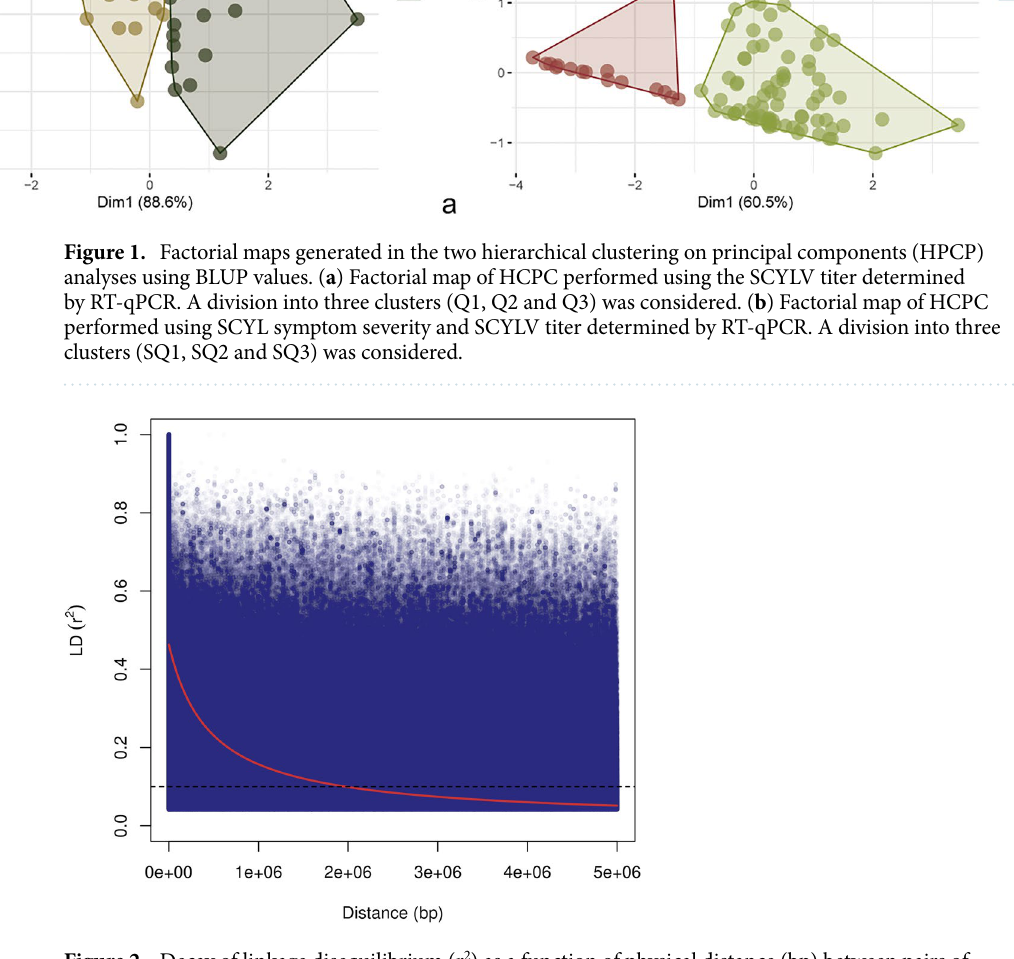
Figure 2. Decay of linkage disequilibrium (r 2 ) as a function of physical distance (bp) between pairs of 67,007 single nucleotide polymorphisms (SNPs) and insertions and deletions (indels) located on Saccharum spontaneum chromosomes 1A-8A. Only r 2 values with p < 0.05 are